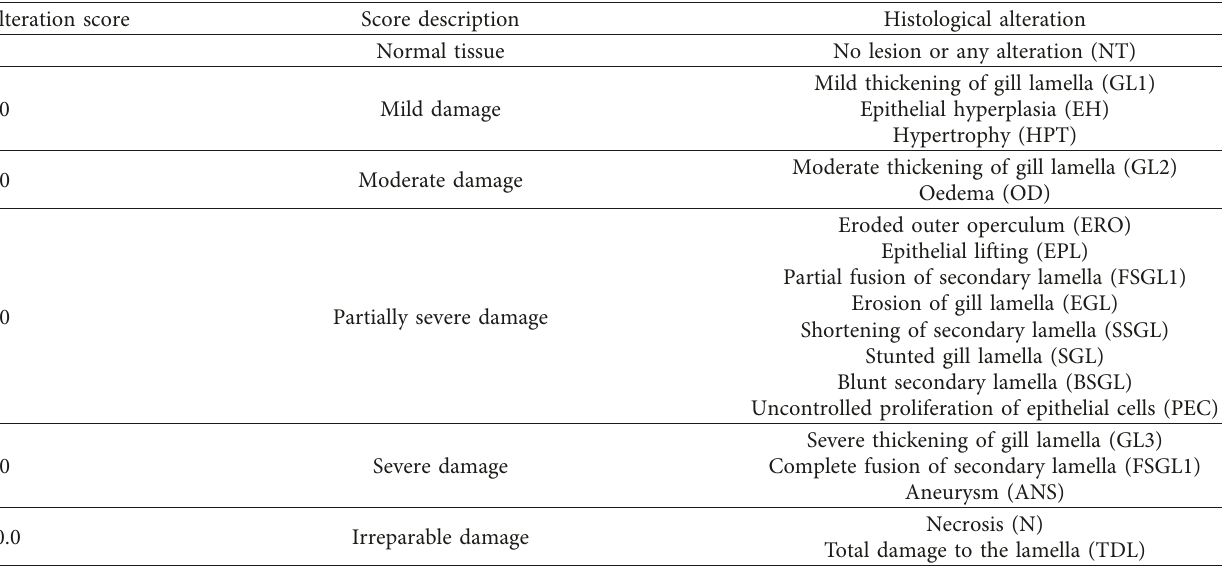
Table 1: Stages of change and histological alterations of the gill.